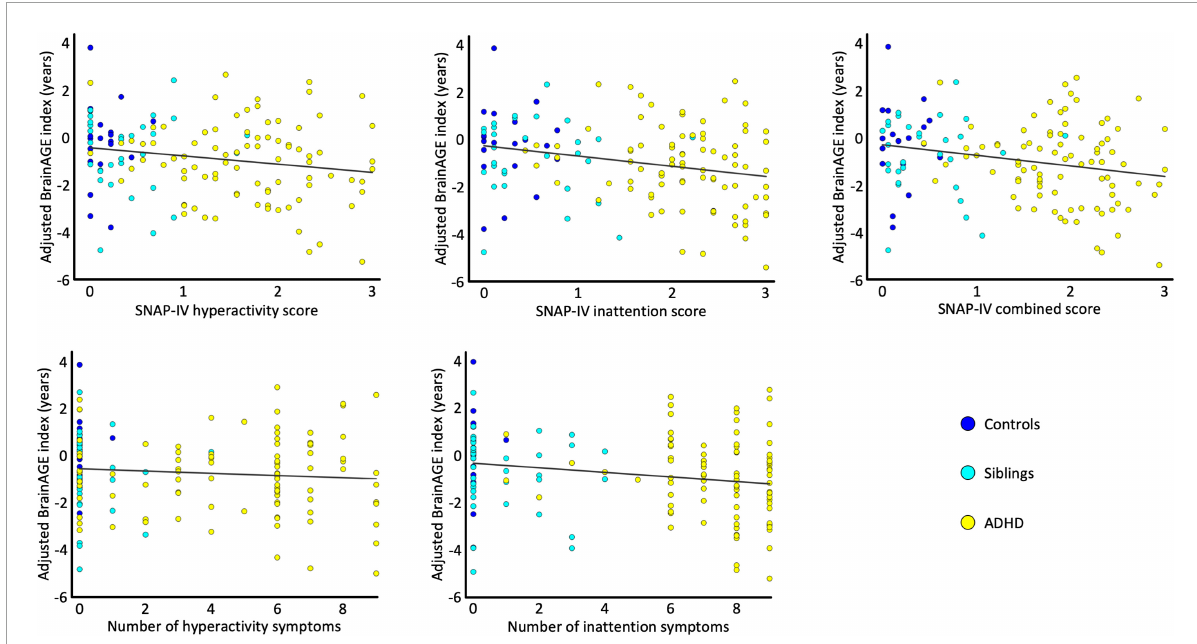
FIGURE2 Correlations. The scatterplots depict the association between the sex-adjusted BrainAGE index and the SNAP-IV hyperactivity scores, the SNAP-IV inattention scores, the SNAP-IV combined scores, the number of hyperactivity symptoms, and the number of inattention symptoms. For each scatterplot the estimated association is plotted as a least-square regression line. All data points are color-coded by group (control children in blue, unaffected siblings in cyan, and children with ADHD in